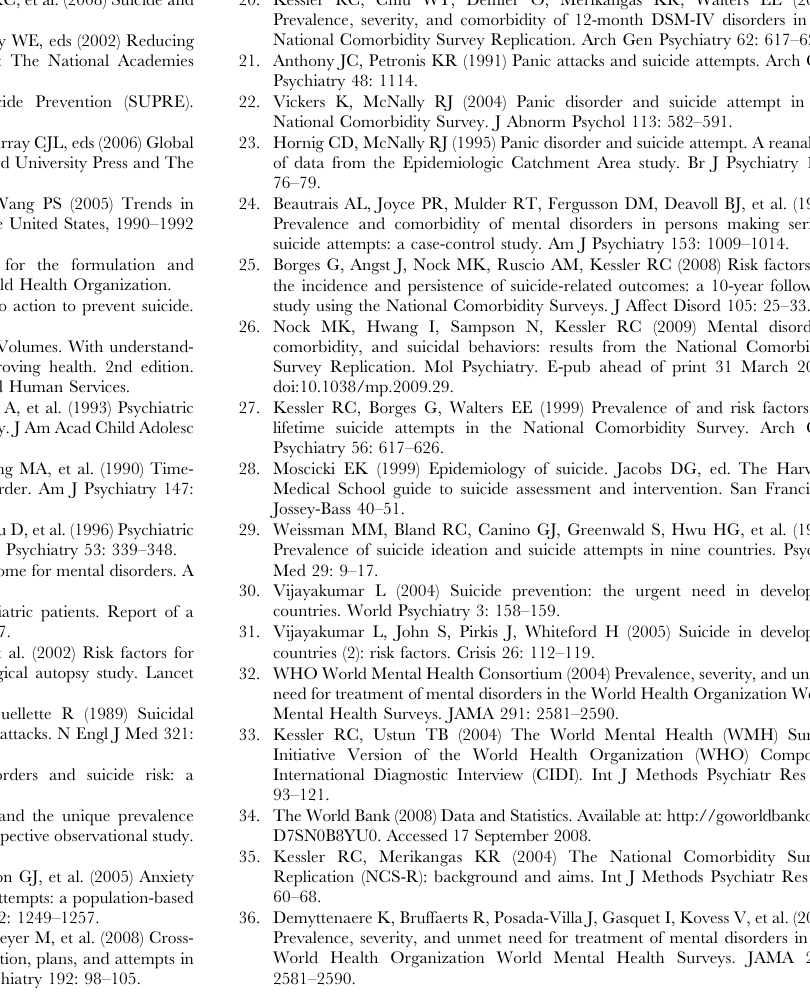
Table S2 Prevalence of lifetime DSM-IV disorders among suicidality in developing countries.